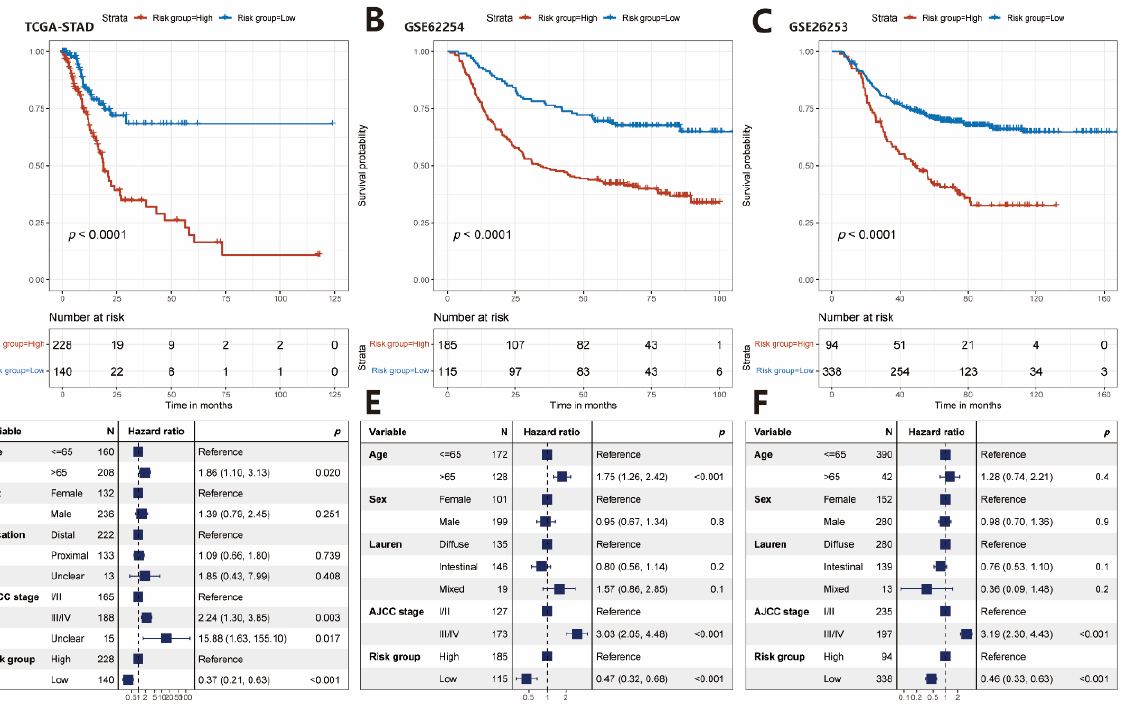
Figure 2. Relationship between risk score and patients’ survival in different cohorts of GC patients. K–M curves of OS according to risk groups in the TCGA-STAD discovery cohort ( A ), GSE62254 validation cohort ( B ), and GSE26253 validation cohort ( C ). Forest plot of multivariate regression analyses showing the association between risk score and patients’ survival in the three cohorts ( D , E , F ).